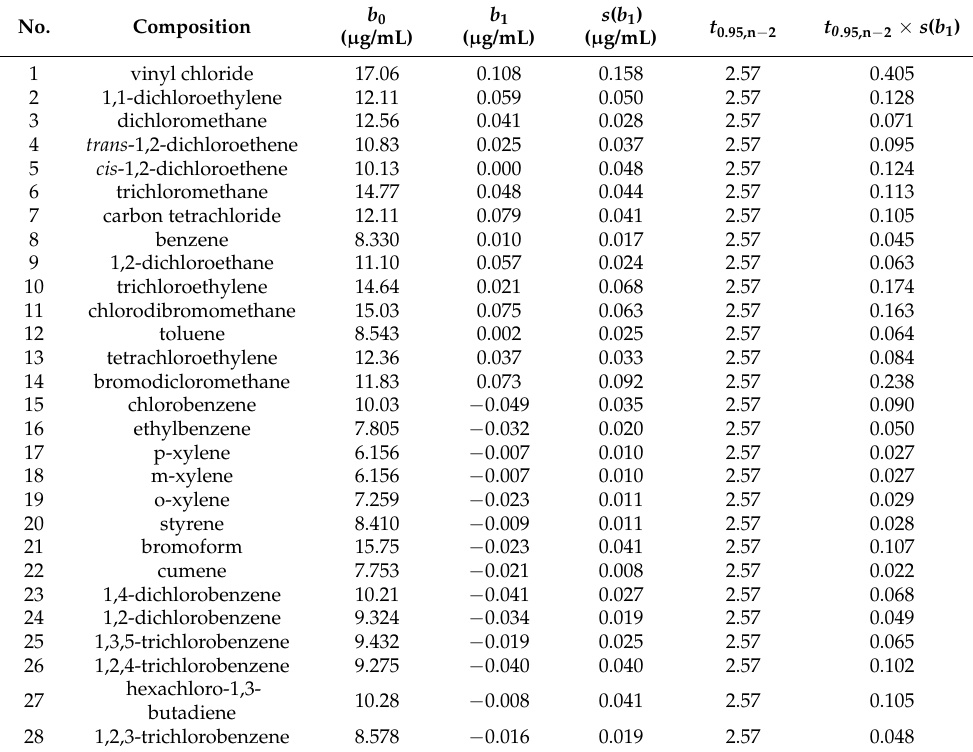
Table 3. Stability study for VOCs spiking solution stored at 4 ◦ C.